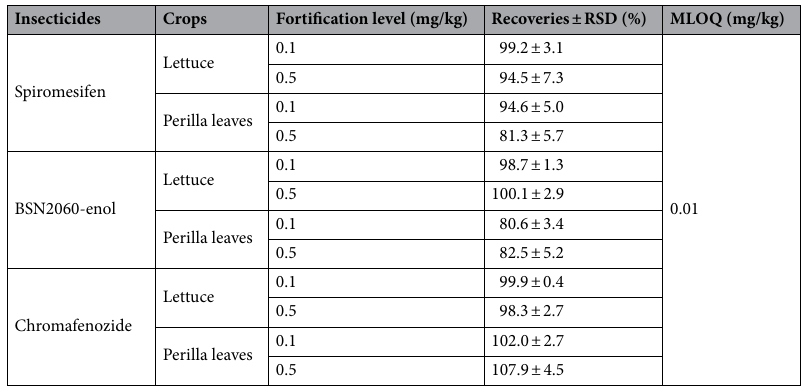
Table 1. Average recoveries and MLOQs of insecticides in lettuce and perilla leaves. MLOQ method limit of quantitation, RSD relative standard